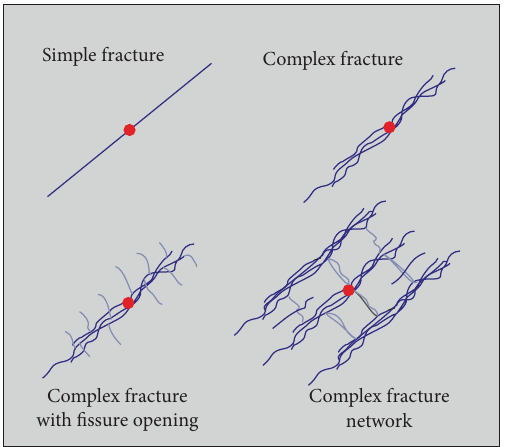
Figure 2: Classification of fracture from simple to complex